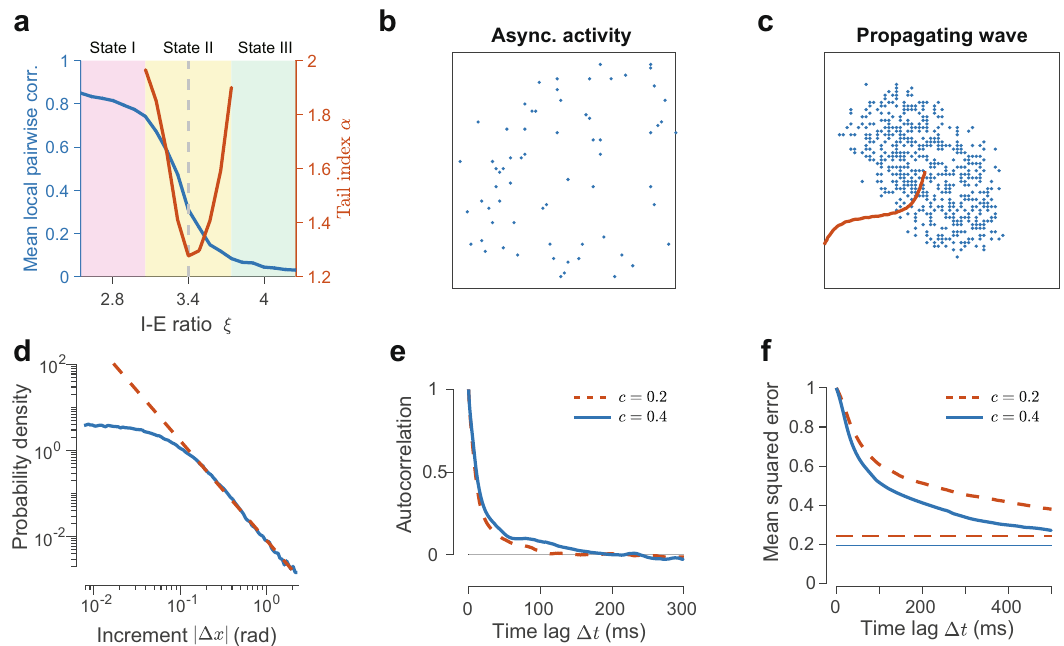
Fig.4|NeuralcircuitmechanismofFNS.a Phasediagramoftheemergentactivity states in the spiking neural circuit as the inhibition-to-excitation ratio ξ varies. Neural correlations (blue line) of spike counts reveal a state transition from the asynchronous state (State III, weak correlation) to propagating wave state (State I, strong correlation). Only within the transition regime (State II), the increment distribution of the trajectory of the localized spiking pattern follows the α -stable distributionwithitspower-lawtailindex α smallerthan2,indicatingthepresenceof fractionalLévy motion. b , c Snapshots ofthe spiking patternfor State I and State II